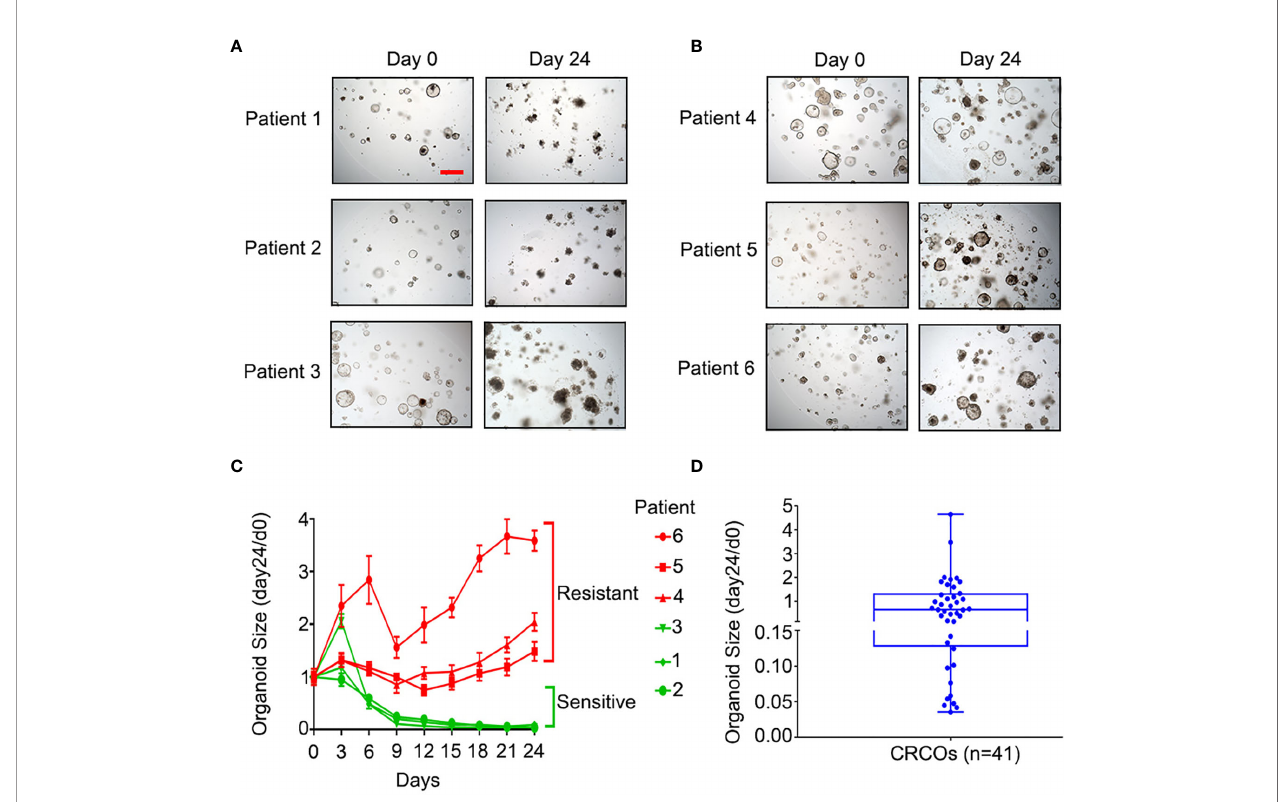
FIGURE 2 | Sensitivity of CRCOs to 5-Fu. (A) Representative bright- fi eld images of 5-Fu-sensitive CRCOs at day 0 and day 24 after 10- m M 5-Fu treatment in three selected cases. The CRCOs with disrupted structures are dead and do not have the ability to repopulate. (B) Representative bright- fi eld images of 5-Fu-resistant CRCOs at day 0 and day 24 after 10- m M 5-Fu treatment in three selected cases. CRCOs with complete structures are alive and have the ability to repopulate . Scale bar, 200 m m. (C) CRCO size change after 10- m M 5-Fu treatment in six selected cases. The data shown are means with SEM from 8 duplicates. (D) Box plot of CRCO size change (day24/d0) in all of the 41 cases. Within the box, the horizontal blue center line denotes the median value (50th percentile), while the box contains the 25th to 75th percentiles of the distribution of values. The blue whiskers mark the minimum and maximum of the values. CRCOs, colorectal cancer organoids; 5- Fu, 5- fl uorouracil; SEM, standard error of